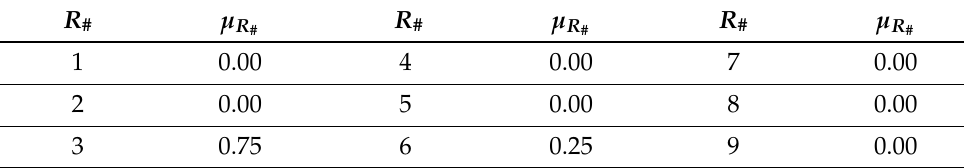
Table 6. Fuzzy rules